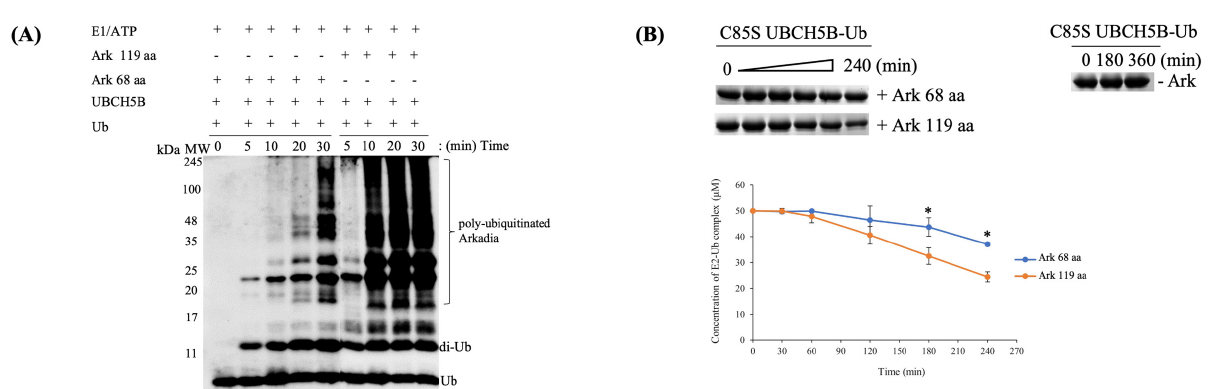
Figure 3. ( A ) In vitro auto-ubiquitination assays of Ark 68 aa and Ark 119 aa polypeptides. Control reactions were conducted without (addition of) Arkadia. All auto-ubiquitination experiments were performed in triplicate. Di-Ub: Ubiquitin dimers. ( B ) Top, oxyester hydrolysis assays showing the disappearance of C85S UBCH5B-Ub in the presence of Ark 68 aa and Ark 119 aa polypeptides, over time. Control reaction demonstrating Oxyester complex’s stability over time. Bottom, densitometry quantification from gels (bars indicate range of experimental duplicates). * Indicates statistically significant difference ( p value ≤